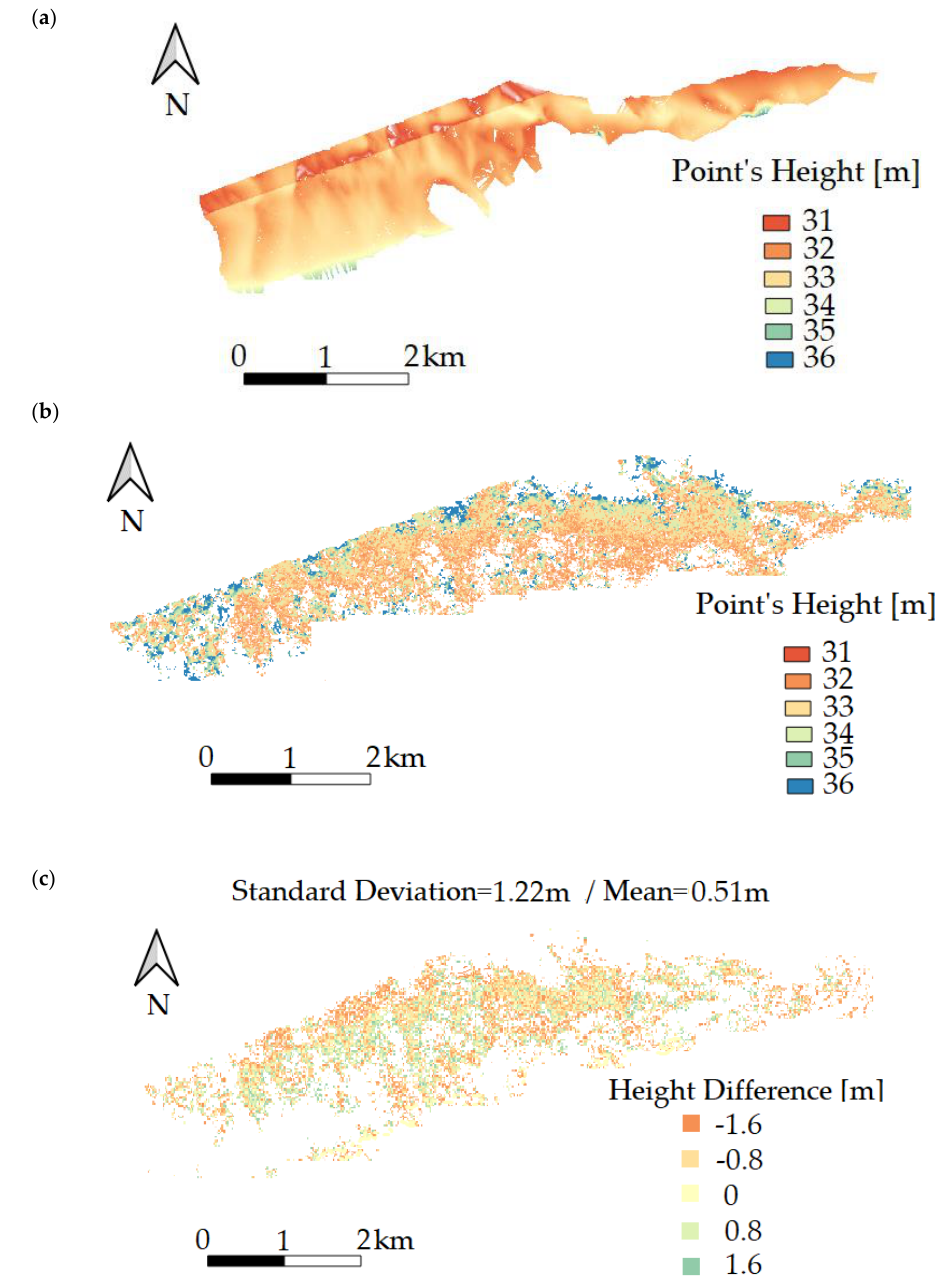
Figure 8. Bathymetry of the study area, acquired in conditions 4–5, with ( a ) a scanner performing a measurement up to a Secchi depth of 0.7; ( b ) aerial photographs; and ( c ) the height difference between these models.